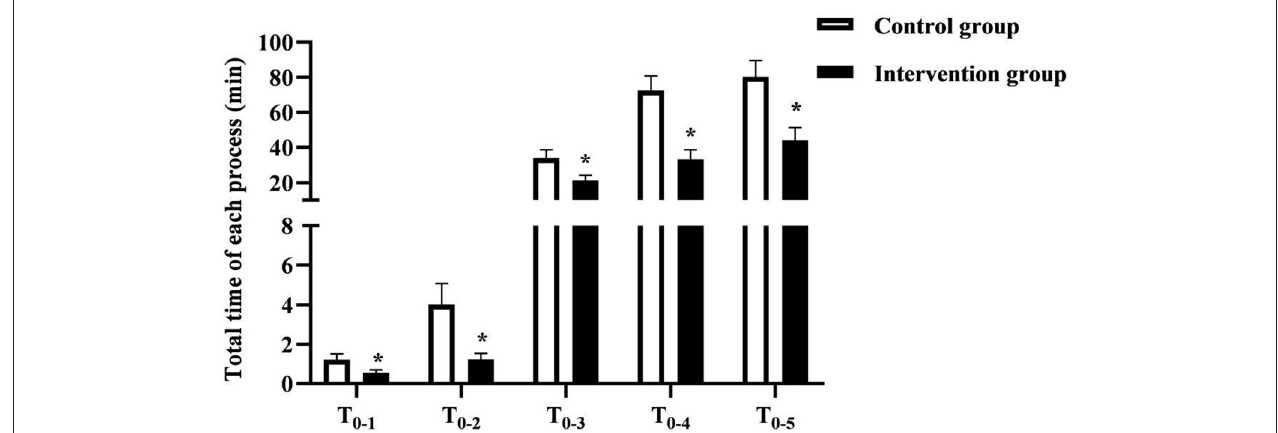
FIGURE 2 | The total time of each procedure in the two groups of patients. * was the comparison of similar items between groups, P < 0.05.